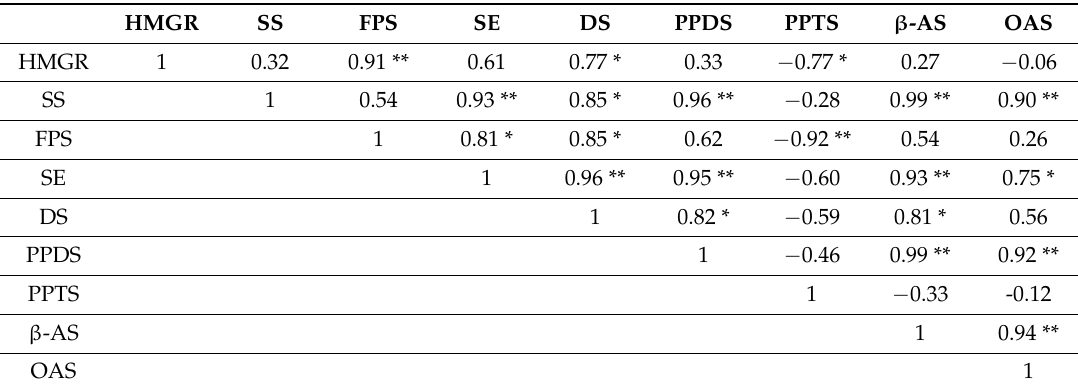
Table 6. Correlation analysis of gene expression in leaves at different growth